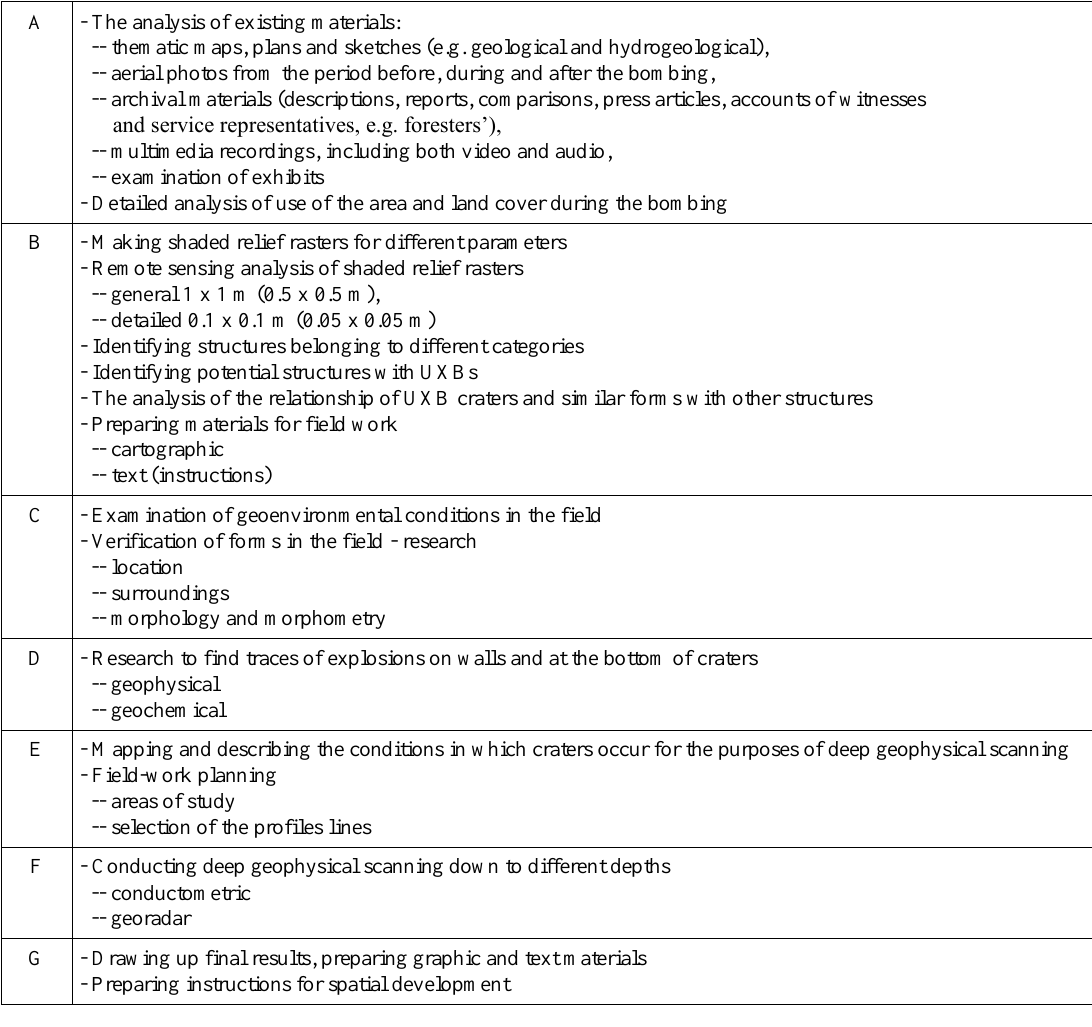
Table 1. Algorithm for UXB studies in reclaimed (A-G) and unreclaimed (B-G) areas (source: Waga et al., 2022b,